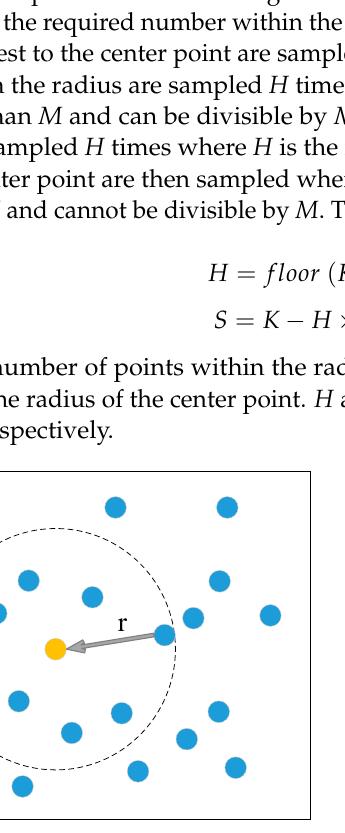
Figure 3. Dividing the local neighborhood of sampling points into groups by the adaptive ball query algorithm. query